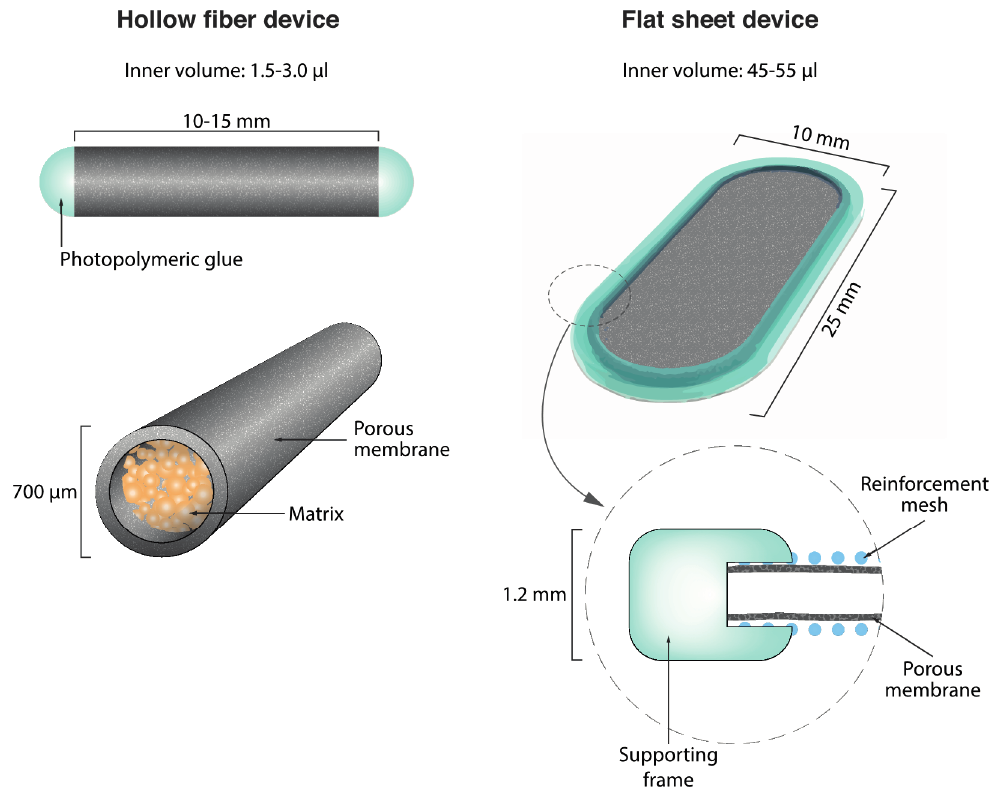
Figure 2. Main types of devices for